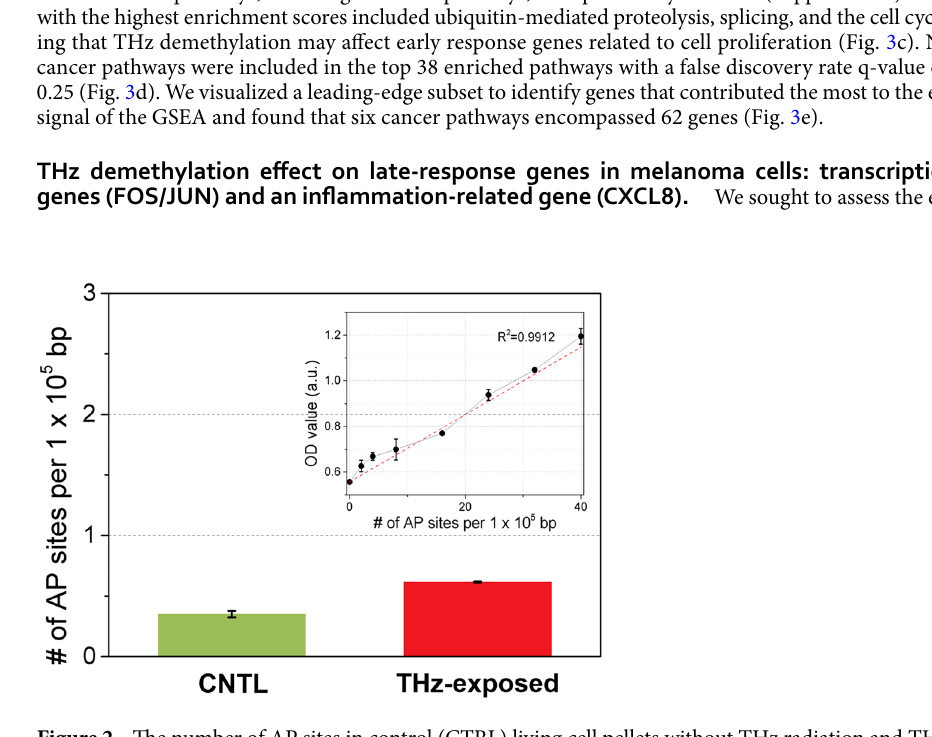
Figure 2. The number of AP sites in control (CTRL) living cell pellets without THz radiation and THz-exposed living cell pellets (THz-exposed) for SK-MEL-3. THz demethylation induced less than 1 AP site per 10 5 bps, which was determined using a standard curve (inset